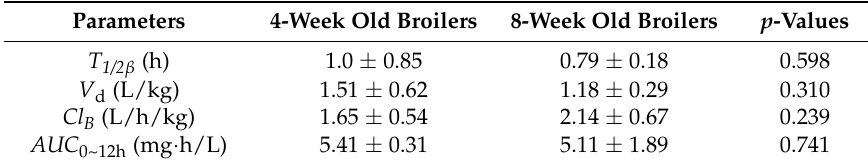
Table 4. Parameters of florfenicol administered intravenously (10 mg/kg) in the 4- and 8-week old broilers.